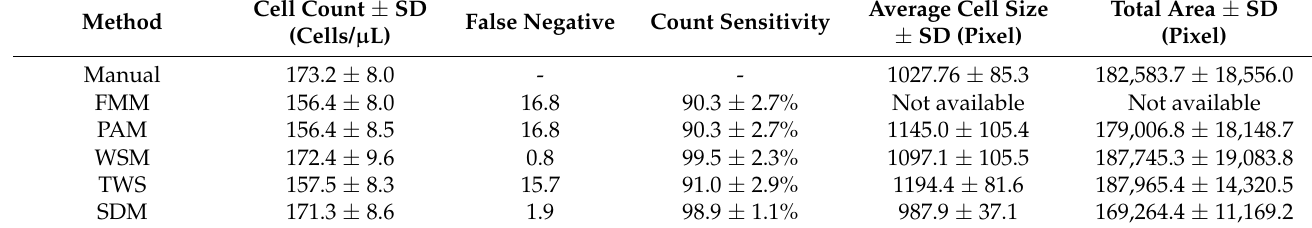
Table 1. Comparison of cell counting performance for Tetrahymena between five different methods.